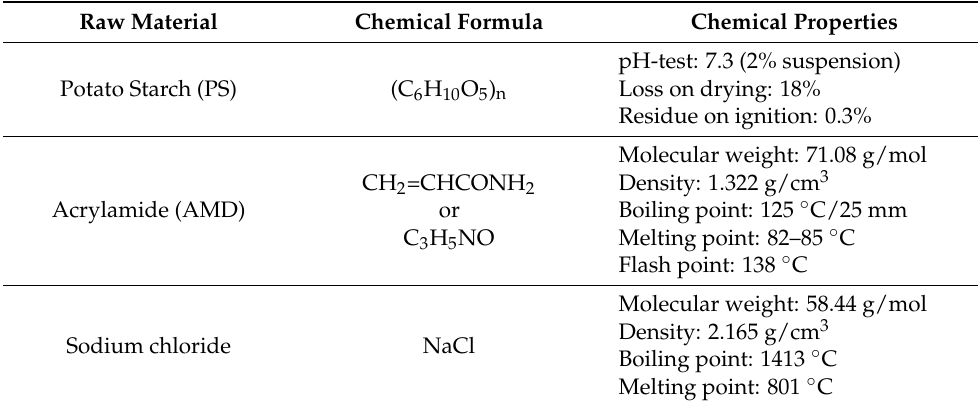
Table 1. Substances used for radiation-induced graft copolymer synthesis. Raw